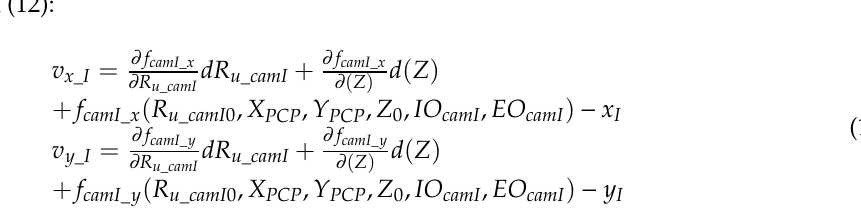
Table 4. Accuracy statistics for the proposed combined adjustment under different types of points’